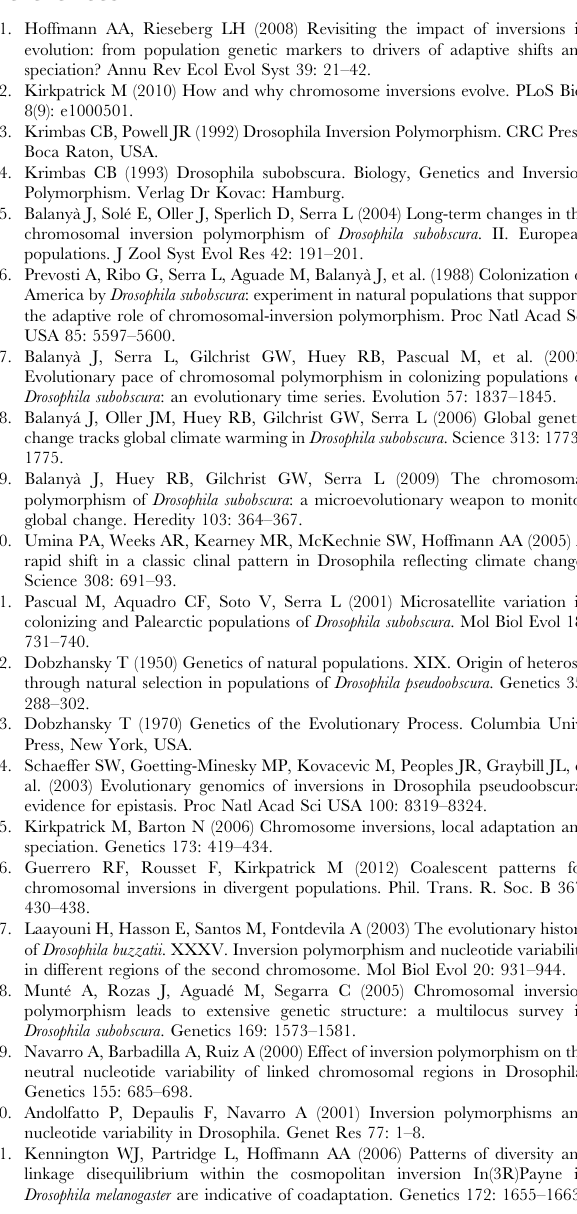
Table S1 Frequency of chromosomal arrangements in the nine studied populations. Table S2 Regression coefficients and significance of inversion frequencies plotted against latitude. Table S3 Levels of genetic variability (expected hetero- zygosity) of all loci for the populations and arrange- ments analysed. Table S4 ANOVA for each chromosome for the effects of population and arrangement as fixed factors and locus as random factor on the arcsin tranformed expected heterozygosity.